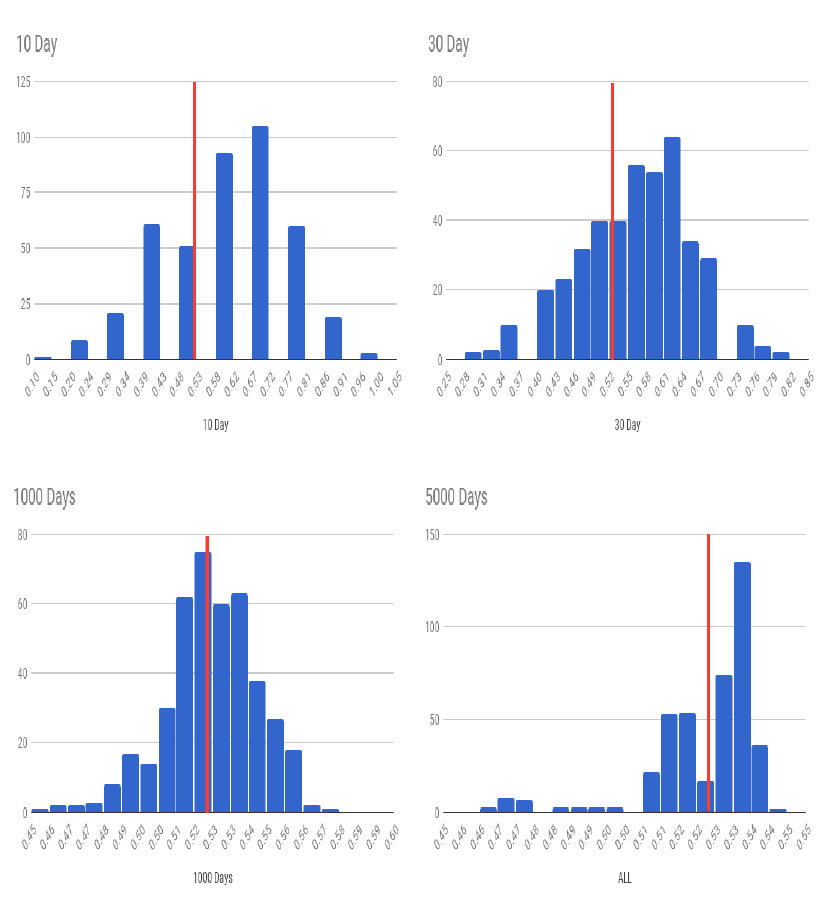
Figure 9. Histograms of the results from all experiments, where the test data was in-sample (IS). The four plots are, reading left to right, top to bottom, the cases when F = 10, 30, 1000, 5000 days, respectively. The red line is at the 52.7% accuracy cut